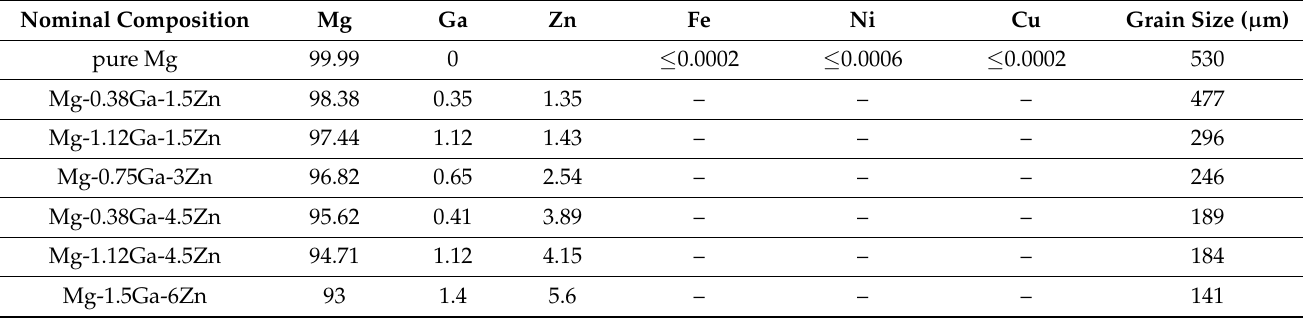
Table 1. Chemical composition (wt.%) and grain size of pure Mg and as-cast Mg-Ga-Zn alloys.